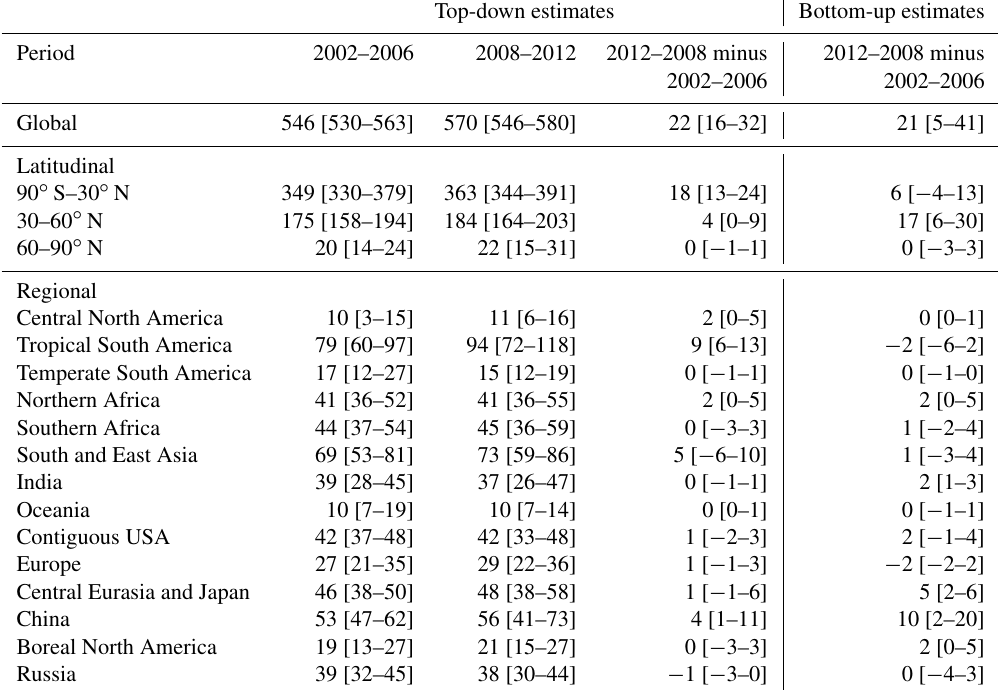
Table 3. Average methane emissions over 2002–2006 and 2008–2012 at the global, latitudinal, and regional scales in Tg CH 4 yr − 1 , and differences between the periods 2008–2012 and 2002–2006 from the top-down and the bottom-up approaches. Uncertainties are reported as a [min–max] range of reported studies. Differences of 1Tg CH 4 yr − 1 in the totals can occur due to rounding errors. A minimum of 3 years was required to calculate the average value over the 5-year periods, and then the difference between the two periods was calculated for each approach. This means that 5 inversions are used to produce these values.